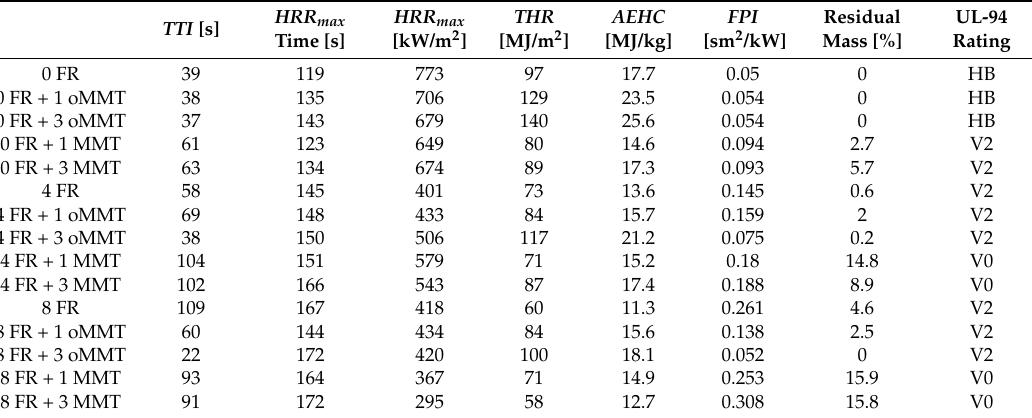
Table 5. Results of cone calorimetry and UL-94